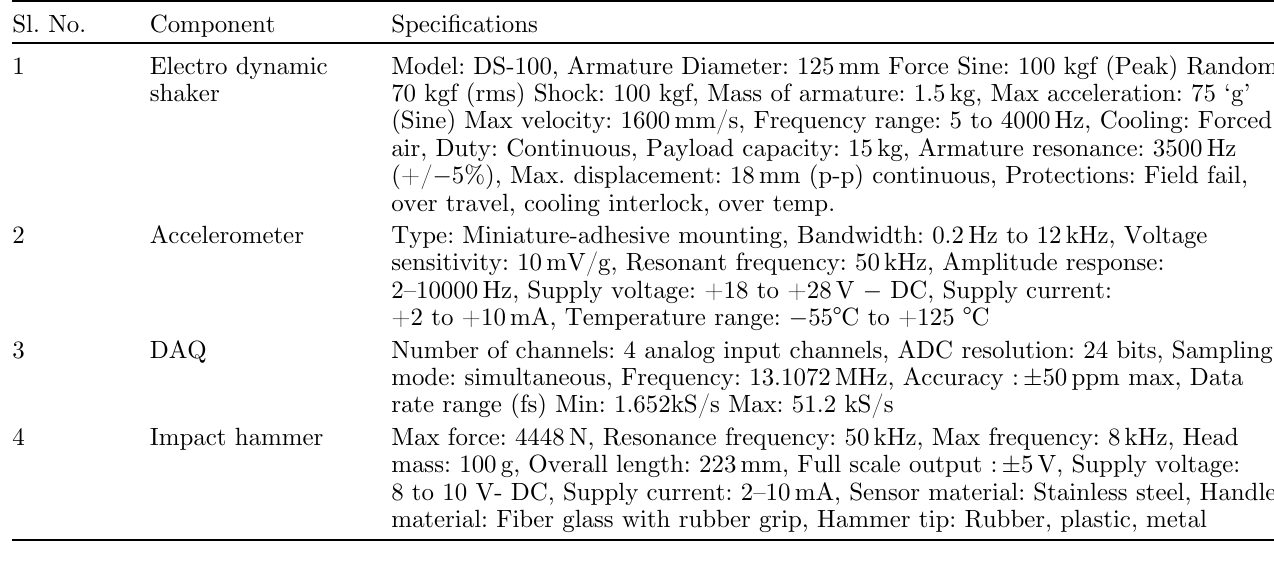
Table 1. Speci fi cations of the components used in the study. Sl. No.